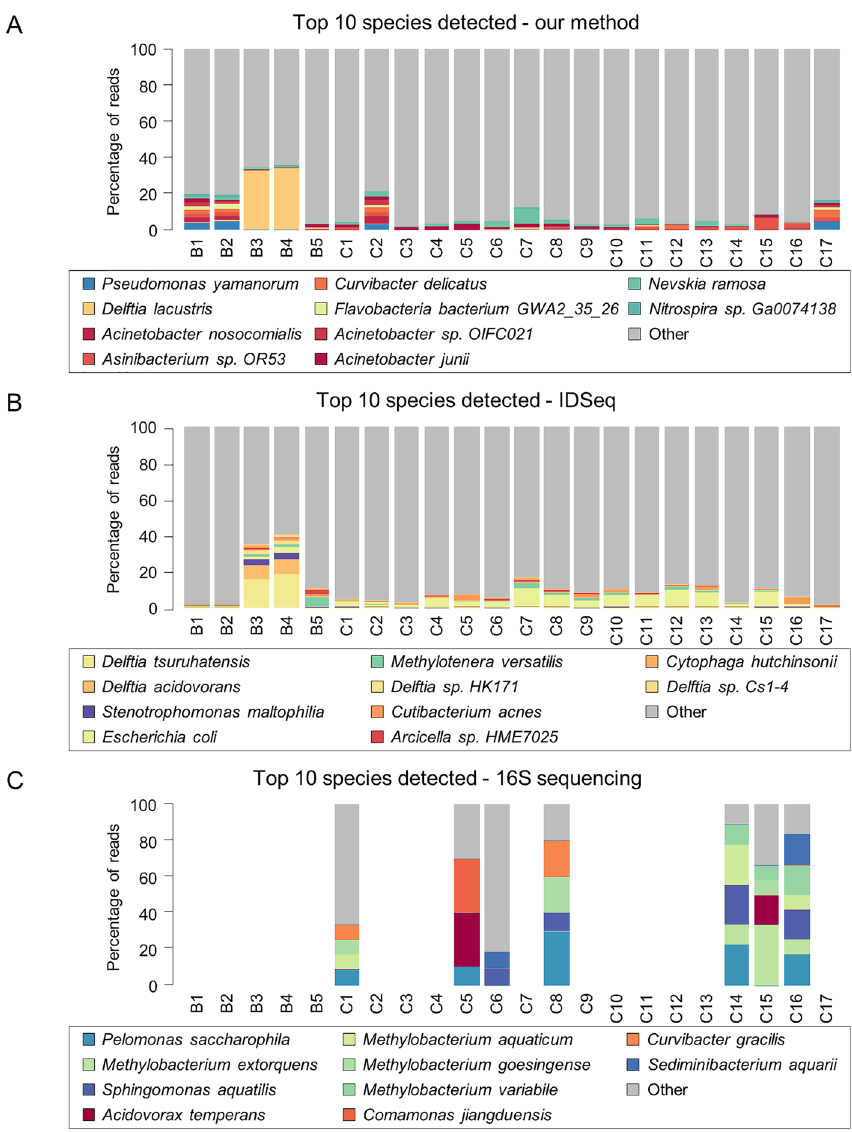
Figure 5. Profiles of all species detected using our method, IDSeq, and 16S sequencing. ( A–C ) Blot plots show the percentages of reads mapped to top 10 most abundant species using ( A ) our method, ( B ) IDSeq, and ( C ) 16S PCR subcloning and sequencing. Species were inferred from 16S sequence data by 100% sequence matches to the organisms indicated.